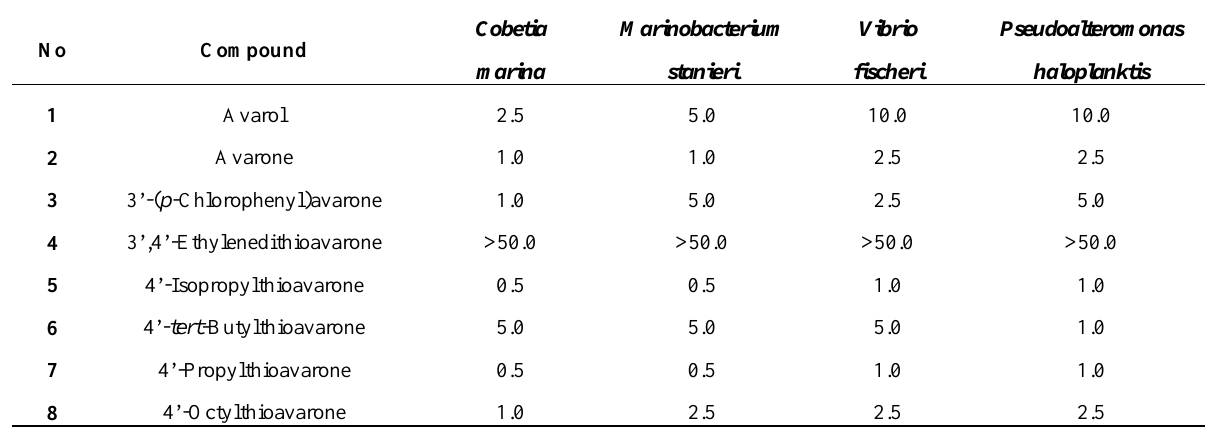
Table 1. Evaluation of antimicrobial activity (MIC, µg/mL).